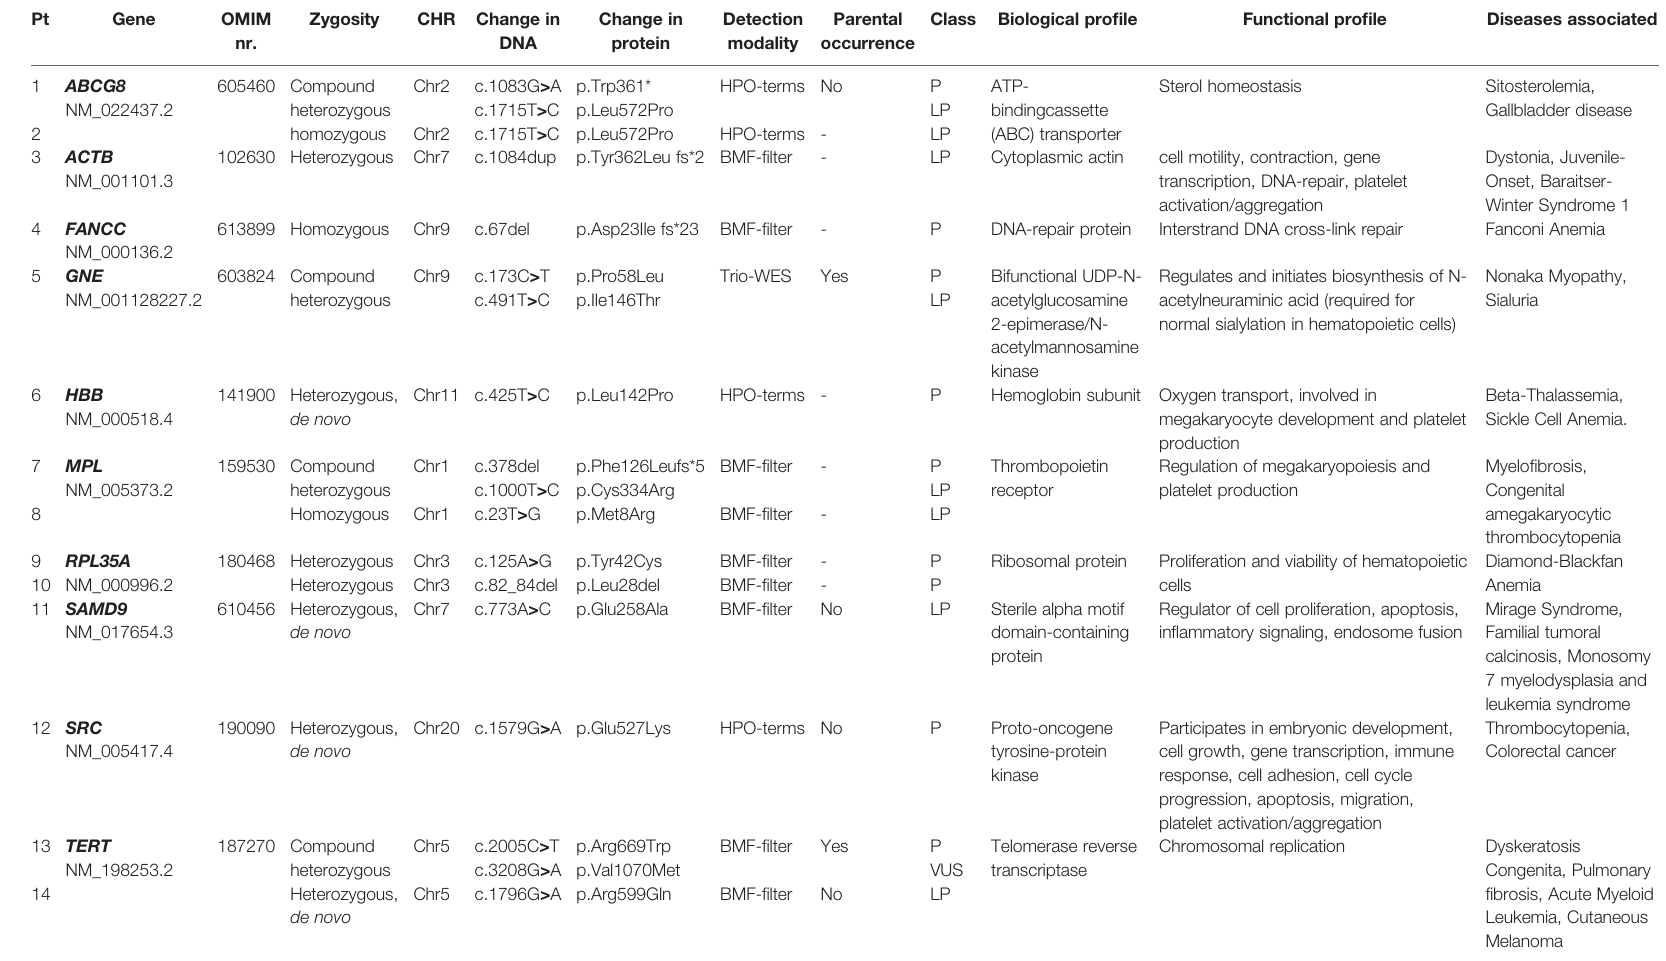
CHR, chromosome; P, pathogenic; LP, likely pathogenic; VUS, variant of unknown signi fi